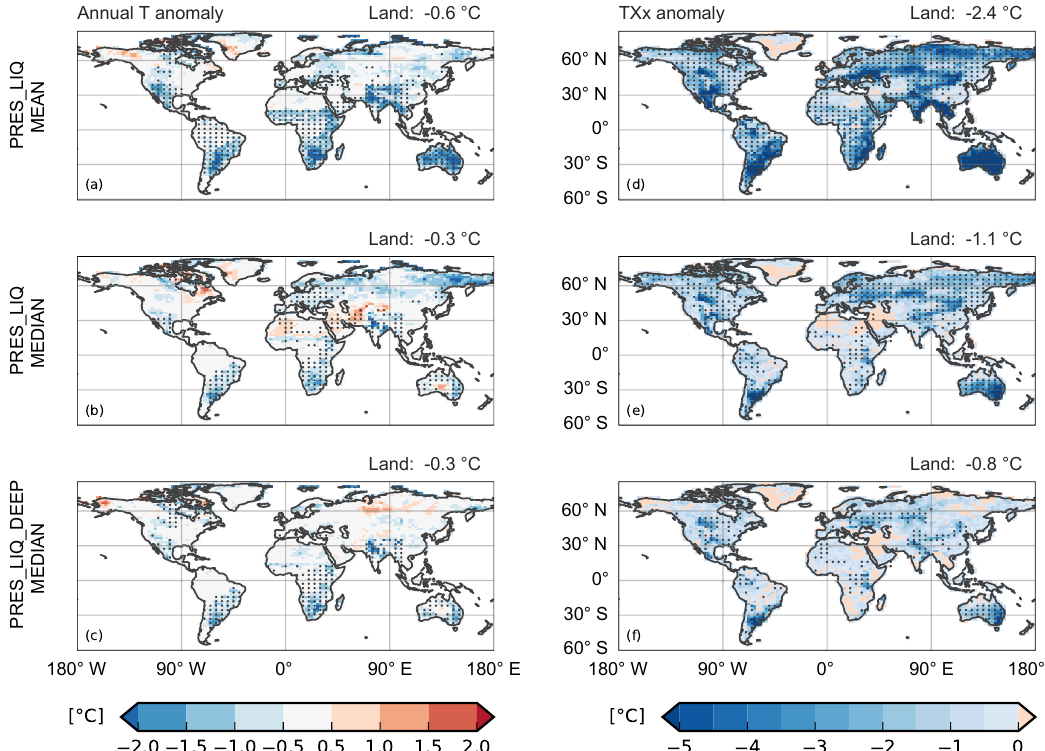
Figure 4. Difference in the median of the simulation with prescribed SM and REF (anomaly) for the period 1971 to 2000. Panels (a) to (c) annual-mean temperature, panels (d) to (f) TXx. Significance is tested with a Wilcoxon–Mann–Whitney U test (e.g. Wilks, 2011). Conducting a significance tests at each grid point increases the probability to falsely reject the null hypothesis (e.g. Wilks, 2016). We therefore control this with the approach described by Benjamini and Hochberg (1995), using a global p value of